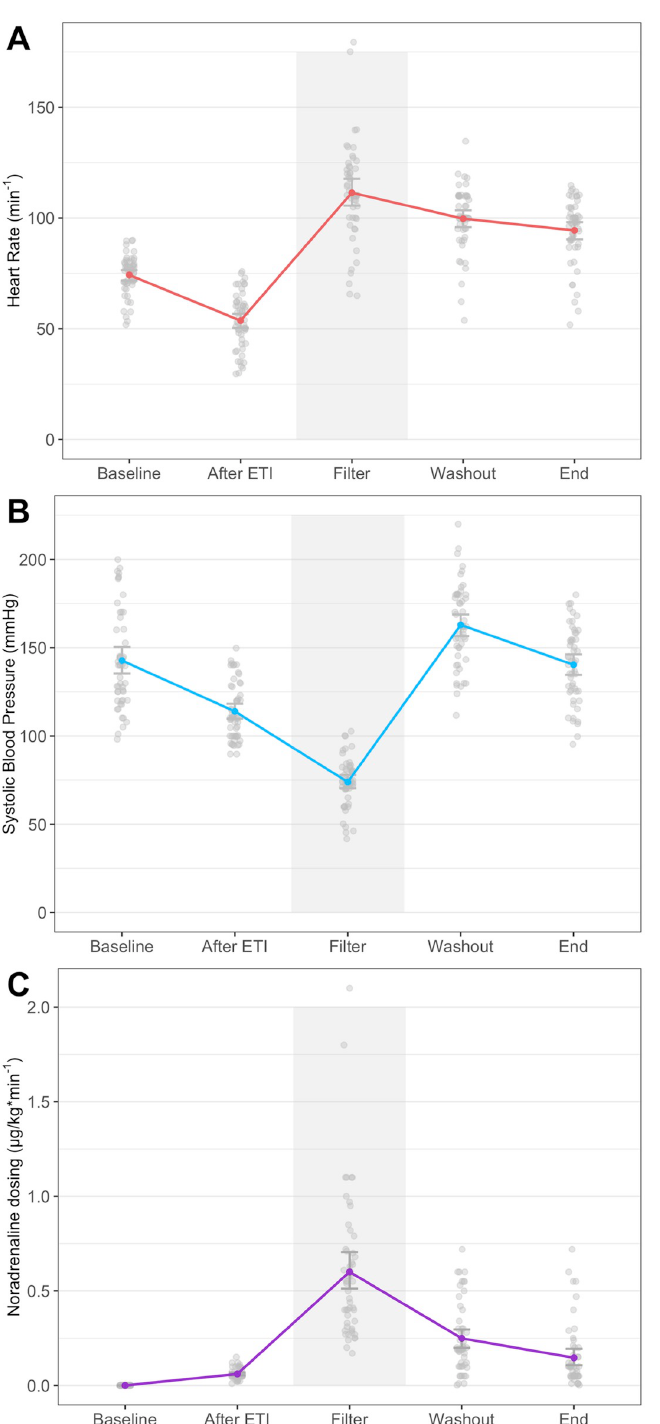
Fig 1. Hemodynamics and noradrenaline dosage at procedure steps.